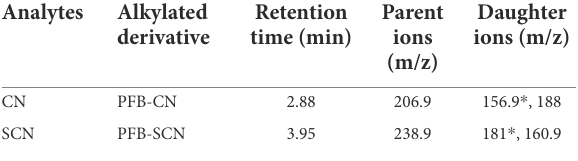
TABLE 1 Main parameters of alkylated CN and